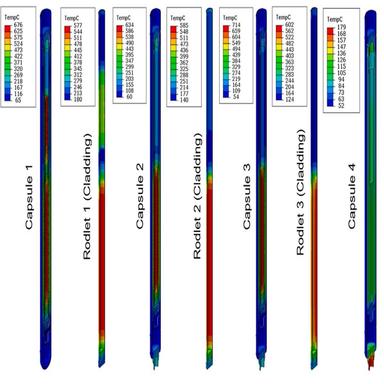
Shows axial cross section views of the IMPACT capsules and rodlets with resulting temperatures (◦C).